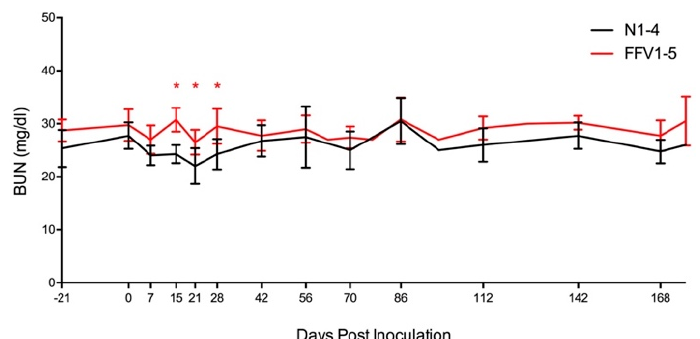
Figure 4. Blood urea nitrogen (BUN) levels are within normal range, but higher in FFV-infected versus naïve control cats. While BUN, one of the biomarkers used to assess renal health, remained within normal range (18–35 mg / dl) for all cats, concentrations tended to be higher in infected cats (red line) compared to naïve cats (black line) on days 15, 21, and 28 pi (red asterisks, P < 0.05). Lines represent mean of BUN measurements for the cats in each group. Vertical lines denote the standard deviation for each grouped measurement.